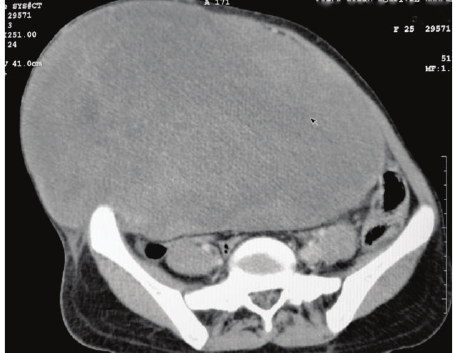
Figure 2: CT scan showing mass arising from anterior abdominal musculature.